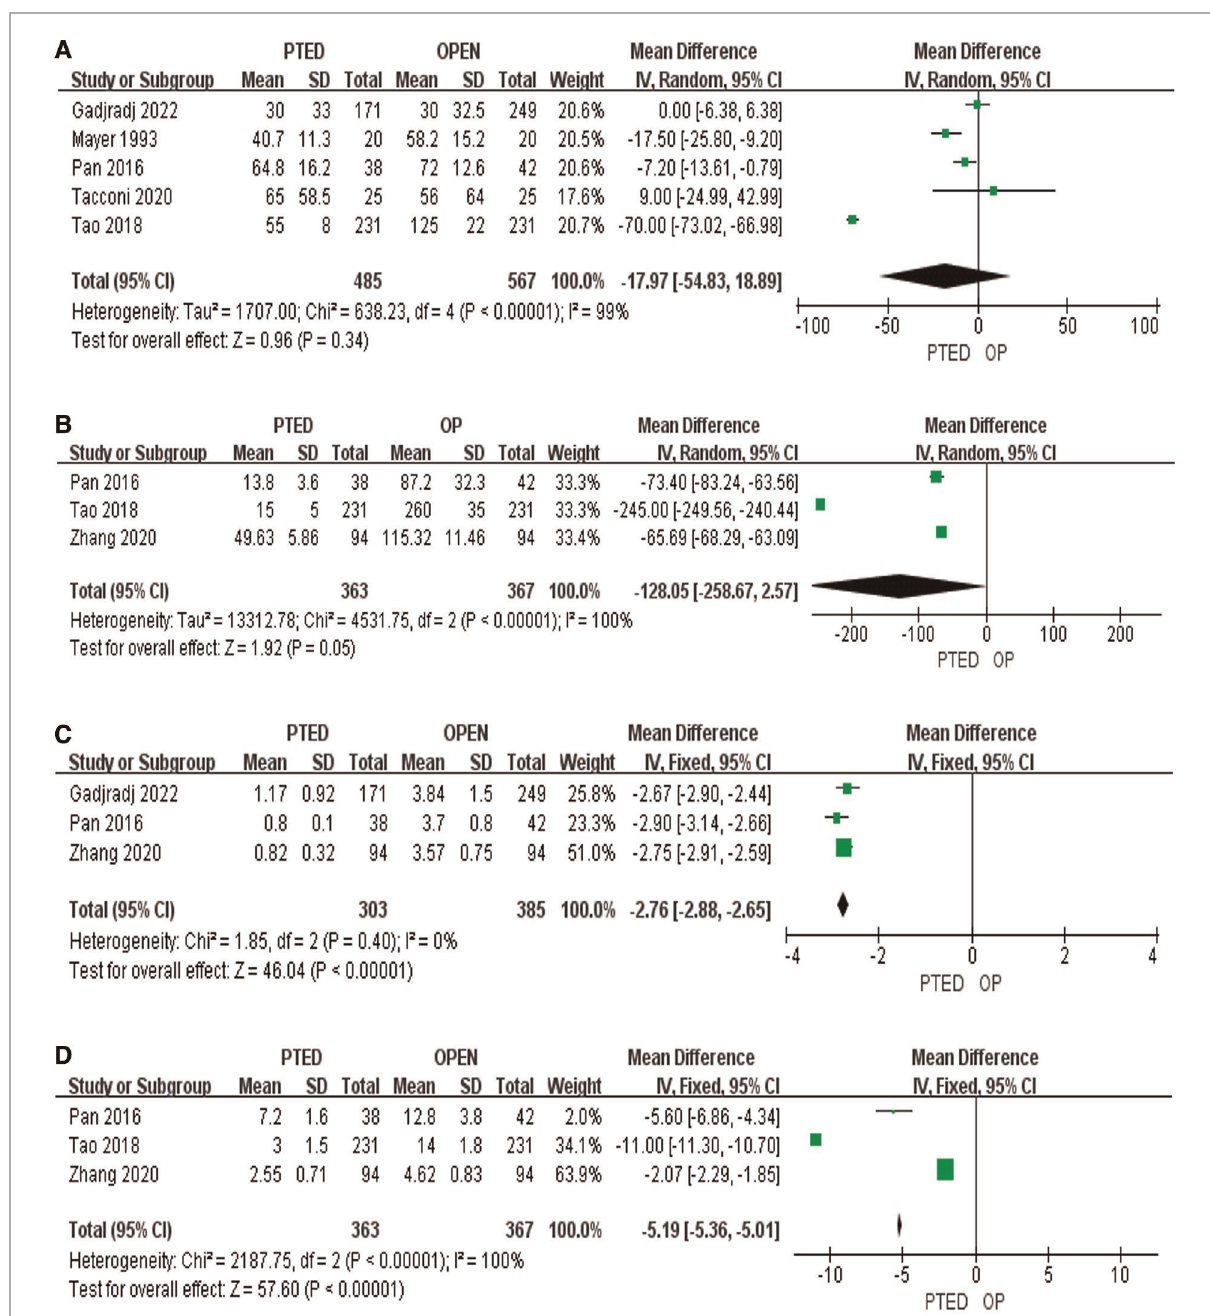
FIGURE 3 Pooling results of the PTED group and the OLD group. ( A ) Length of operation; ( B ) Amount of intraoperative blood loss; ( C ) Length of incision; ( D ) Length of hospital